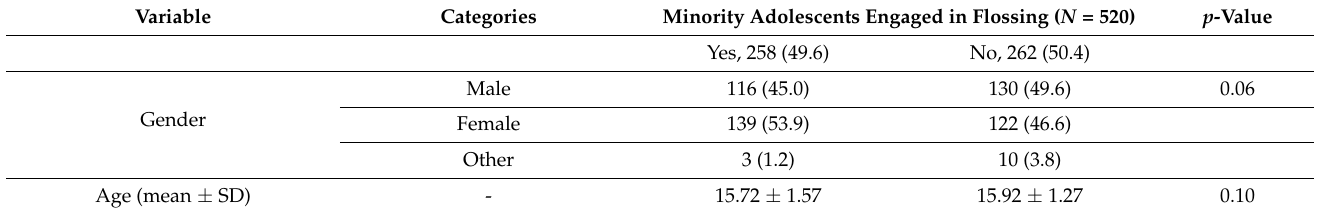
Table 5. Comparing characteristics of minority adolescents who floss vs. those who do not floss ( N =